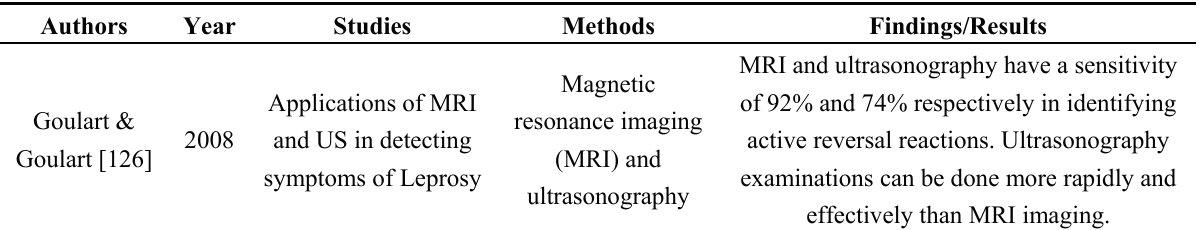
Table 10. Summary of the biomedical engineering technique in leprosy